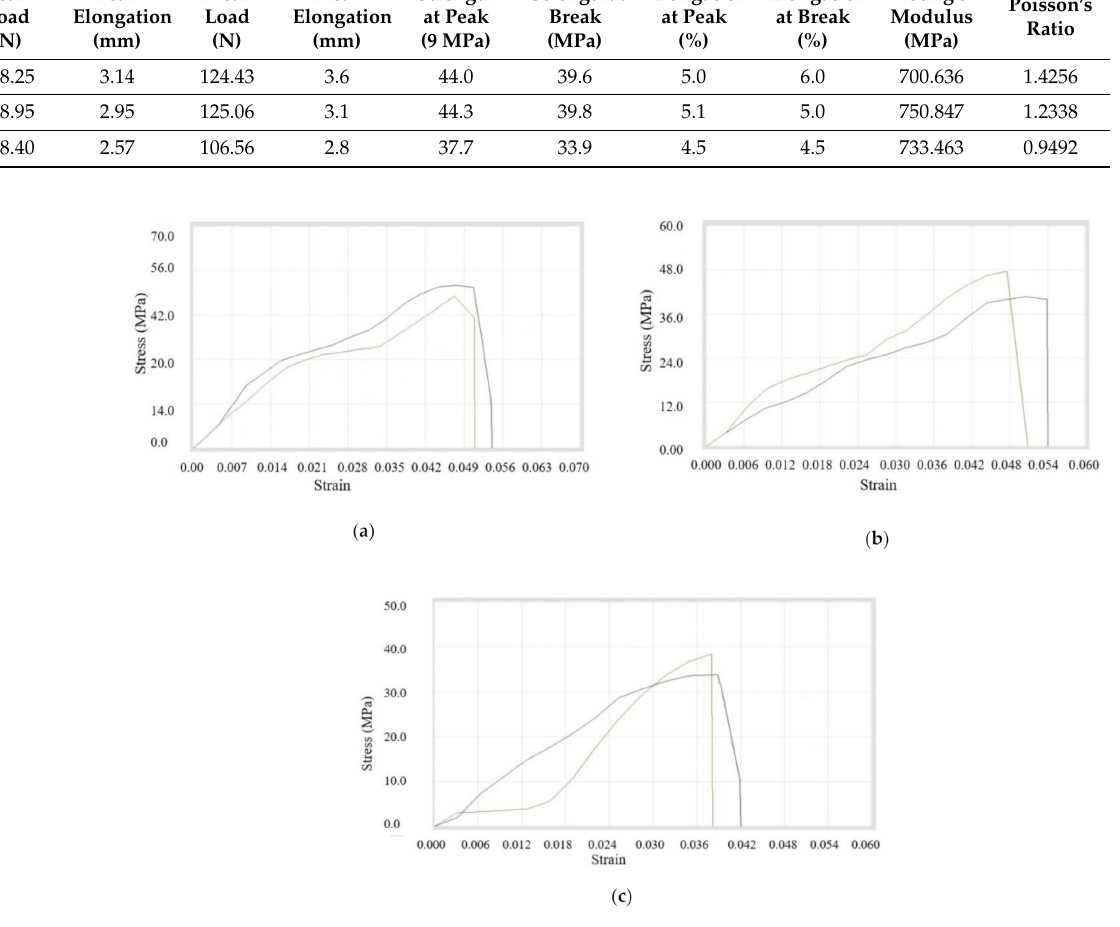
Figure 11. Stress–strain curves for ( a ) (A + B)4 , ( b ) (A + B)9 , ( c ) (A + B)10 composite samples.